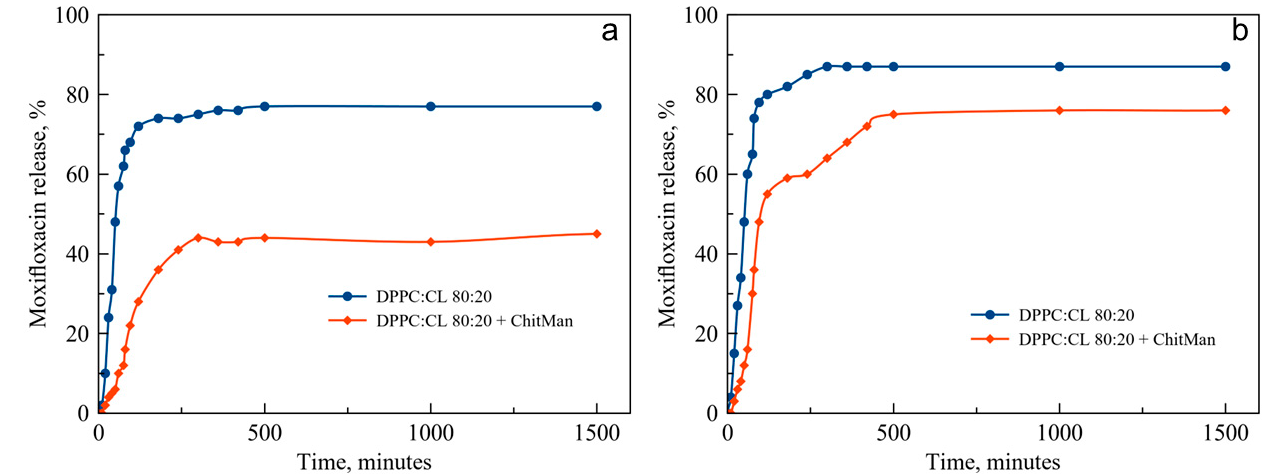
Figure 8. Moxifloxacin release kinetics from DPPC:CL 80:20 liposomes (blue line) and complex of DPPC:CL 80:20 liposomes in complex with ChitMan, BME 5 (red line). ( a ) 0.02 M Na-phosphate buffer solution, pH 7.4, 37°. ( b ) 0.02 M Na-acetate buffer solution, pH 5.5, 37°.